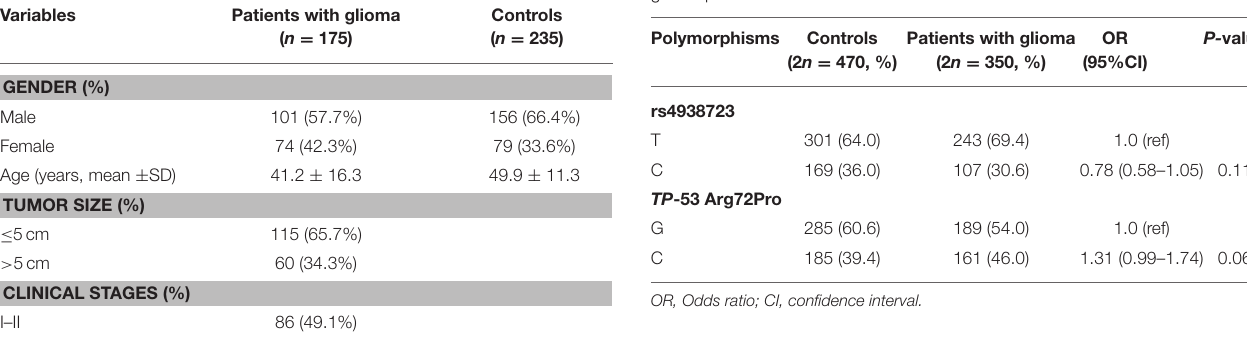
TABLE 3 | The allele frequencies of miR-34b/c rs4938723 and TP-53 Arg72Proin glioma patients and controls.